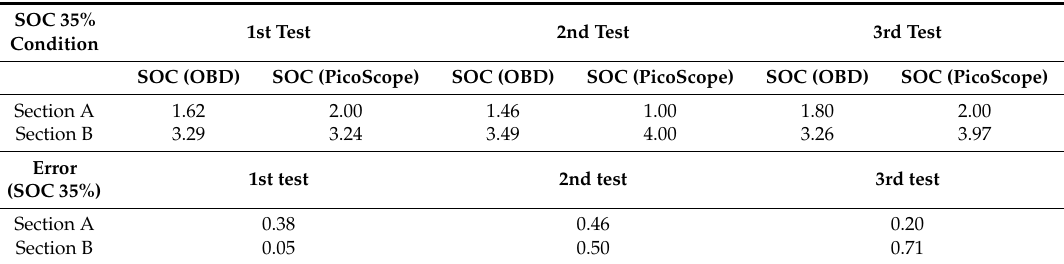
Figure 5. Charge–discharge current and regenerative braking characteristics. Table 4. Comparing Electric Charging Variation between SOC and PicoScope at SOC